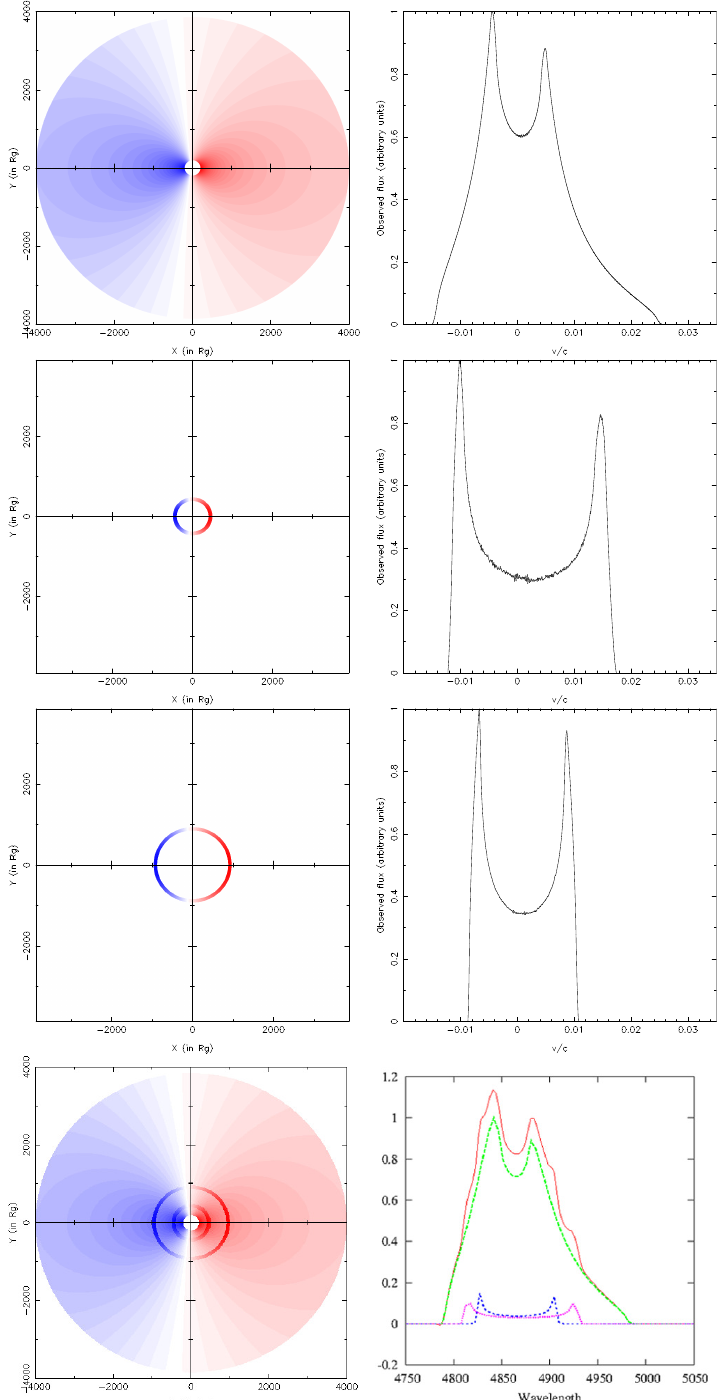
Figure 1. Construction of a synthetic profile as a linear combination of components: AD (R inn = 100 R g , R out = 8000 R g , top panel right) and two additional synthetic ring profile models (R inn1 = 500 R g , R out1 = 600 R g , R inn = 1000 R g , R out2 = 1100 R g mid right panels respectively). The resulting emission line profile is presented as right bottom panel as sum of contribution of AD and two ring profiles with intensity scaled by a factor of 0.1. Representations of disk and ring models are presented on the right